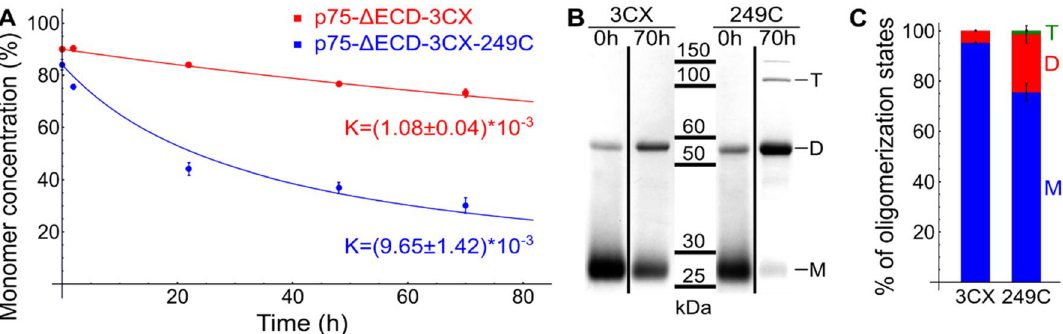
Figure 7. Comparison of rP75-ΔECD-3CX and rP75-ΔECD-3CX-249C oligomerization rates. ( A ) The kinetics of rP75-ΔECD-3CX and rP75-ΔECD-3CX-249C dimerization based on SDS-page analysis (n = 3). k—the reaction rate constant calculated for irreversible second-order reaction. ( B ) The SDS-page analysis of purified proteins incorporated into DMPC:CHAPS (q = 1, LPR = 1,000:1) bicelles at the initial state and after 70 h of incubation without reducing agents (after dialysis). Full-length gels are presented in Supplementary Fig S9. ( C ) Comparison of rP75-ΔECD-3CX and rP75-ΔECD-3CX-249C oligomerization in the membrane of E. coli cells. Both strains were grown under the same conditions and the equivalent amount of cells (normalized to OD600) were harvested through 72 h after induction. After cell lysis, the membrane fraction was separated, solubilized in SDS containing buffer and analyzed by SDS-PAGE. 3CX rP75-ΔECD-3CX, 249C rP75-ΔECD-3CX-249C, M monomer, D dimer, T tetramer. The figure was prepared using the program Inkscape 0.92 (https ://inksc ape.